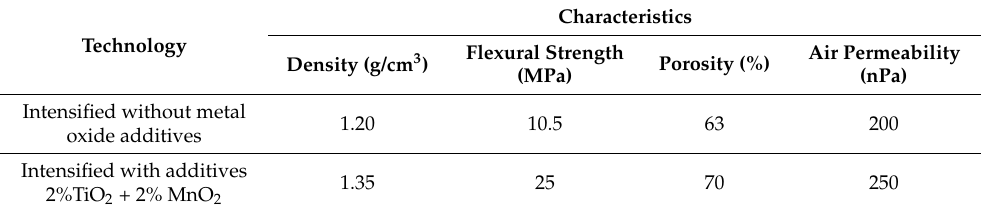
Table 6. Comparative qualitative characteristics of foam ceramic filters manufactured using alu- minum oxide ceramics technology without additives of other metal oxides (100%) and energy-saving technology with two percent additives of titanium and manganese dioxides.